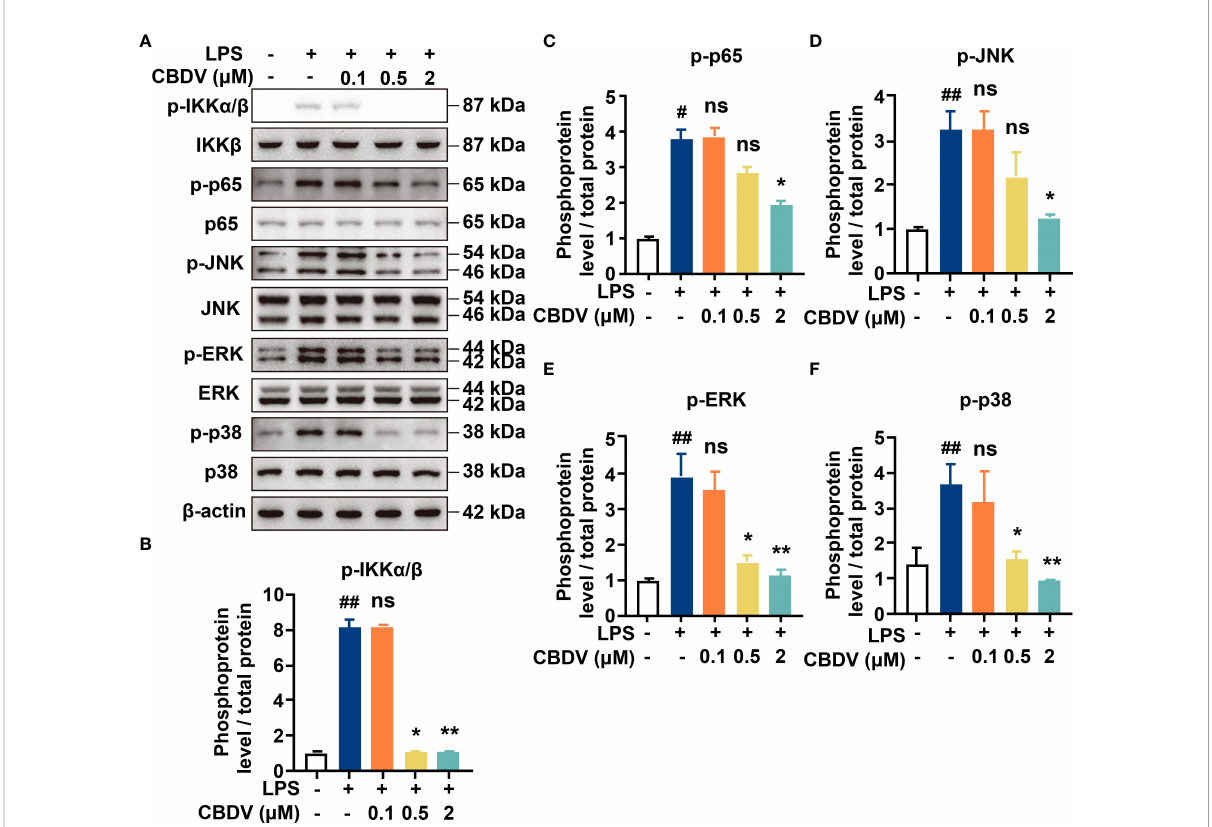
FIGURE 3 Cellular characterizations of CBDV on TLR4 signaling. (A) The effect of CBDV on LPS-induced TLR4 signaling as measured by western blotting. (B-F) The quanti fi cation of the phosphorylation of IKK b (B) , p65 (C) , JNK (D) , ERK (D) and p38 (F) shown in (A) . All experiments were performed three times independently, and data were given as the mean ± S.E.M. The P-value was set at # P < 0.05, ## P < 0.01 versus the control group; *P < 0.05, **P < 0.01 versus the LPS group; ns, not signi fi cant versus the LPS group.